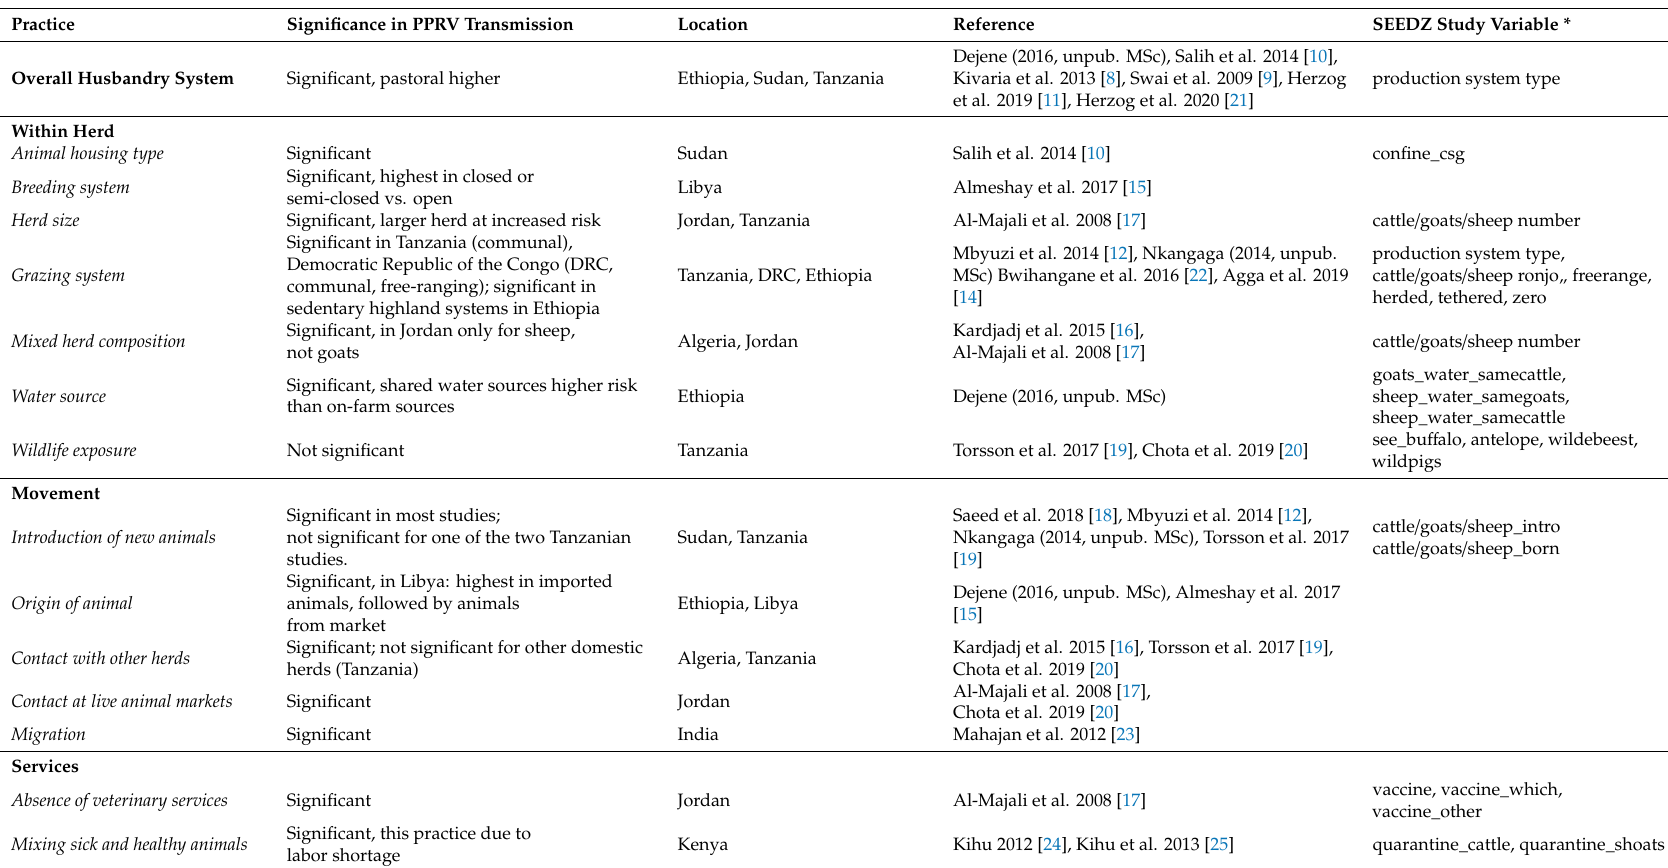
Table 1. Husbandry and PPRV Transmission Risk from Multivariable